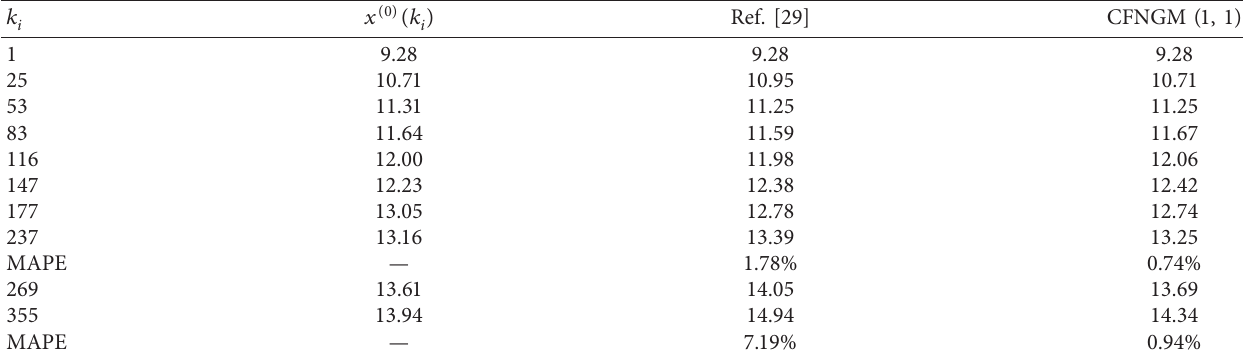
Table 1: Compare the predicted results of different models in the case.